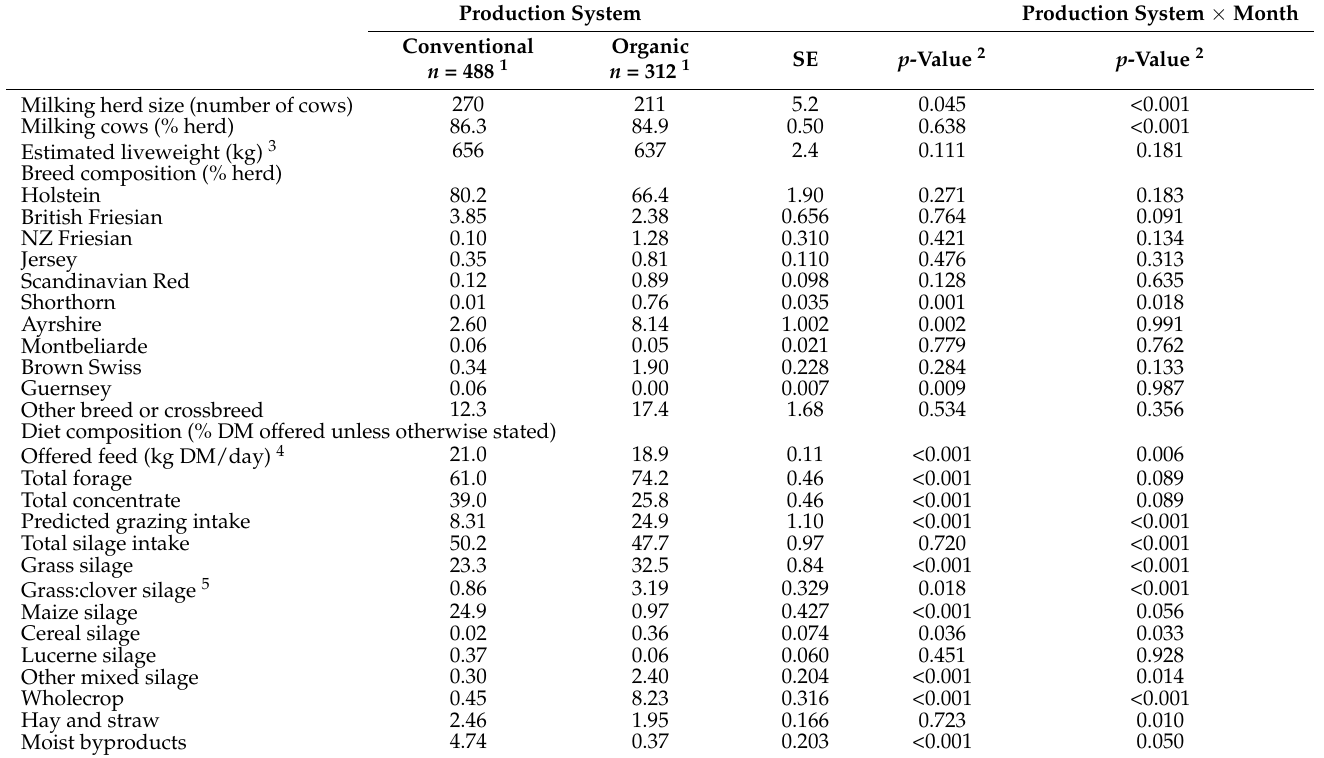
Table 1. Means ± SE and p -values for the breed and diet composition of herds (%) from 67 farms, differing in production systems (conventional or organic) in Southern